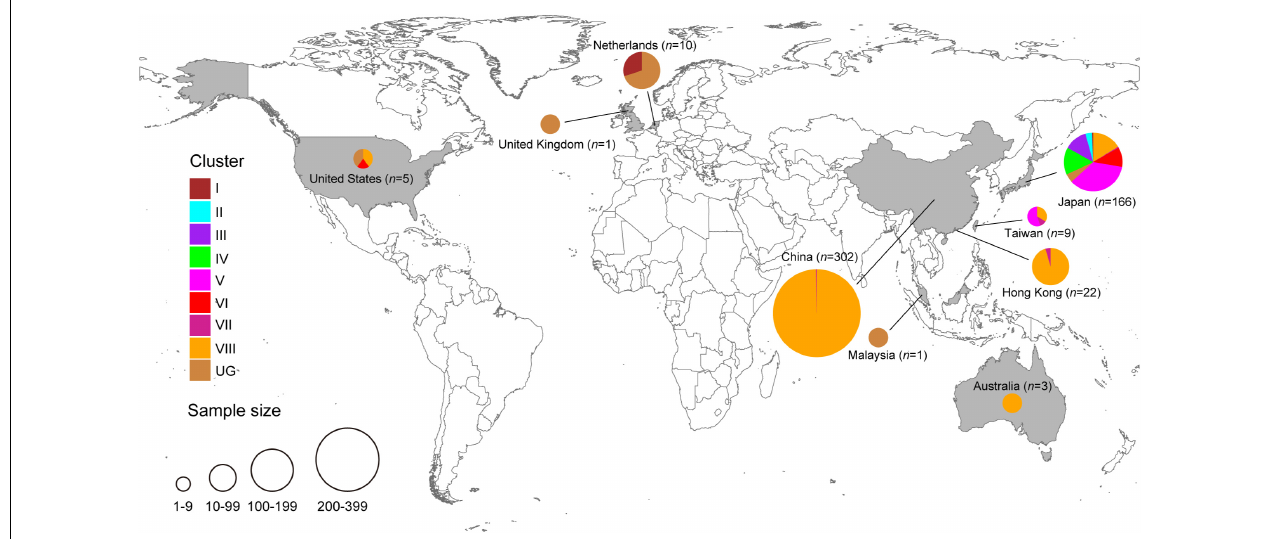
FIGURE 2 | Geographic distribution of HuNoV GII.2 clusters identified in the present study. Each GII.2 cluster identified in this study is color-coded, as shown on the left. The figure was created using Adobe Illustrator CS5 version 15.0.0 software, based on the maps obtained from Craft MAP website (craftmap.box-i.net/). TABLE 2 | Classification and geographic source of human norovirus GII.2 sequences used in the present. Cluster n Geographic